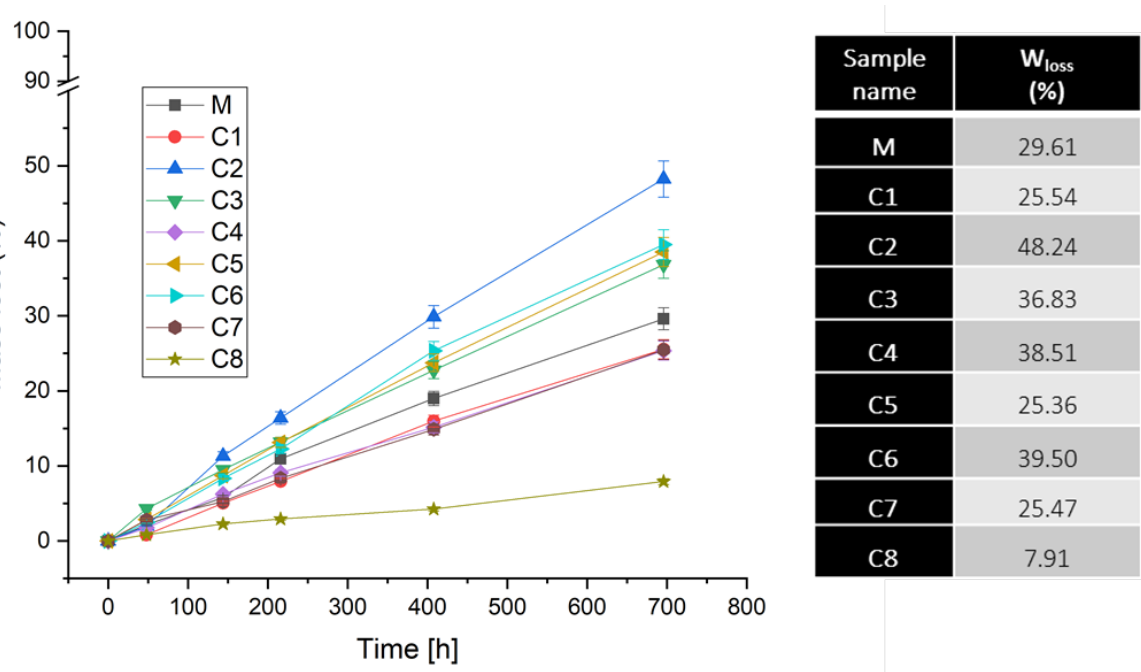
Figure 2. A graph illustrating the weight loss of each piece of glasses over a period of 696 h, respectively 29 days in 10 mL of deionized water.